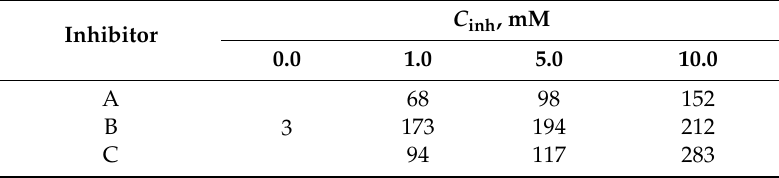
Table 3. Registered time of first corrosion attacks during the salt spray testing ( τ corr , hours).